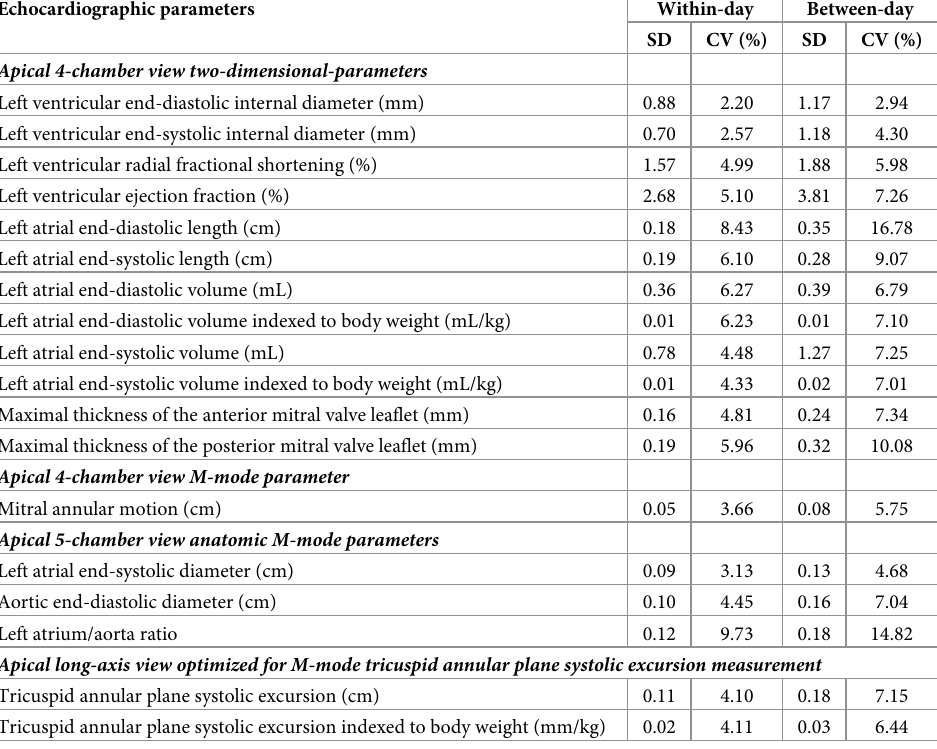
Table 3. Within-day and between-day variability, expressed as standard deviations (SD) and coefficients of varia- tion (CV), of two-dimensional (n = 12), M-mode (n = 3) and anatomic M-mode (n = 3) echocardiographic